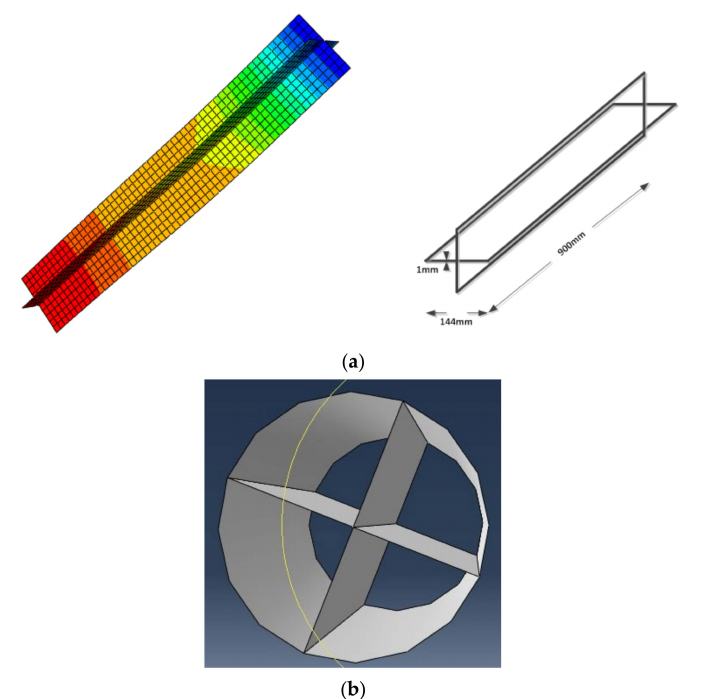
Figure 6. ( a ) The cross-shaped plate inserted in the CFST columns ( b ) The cross-section of the model in ABAQUS.